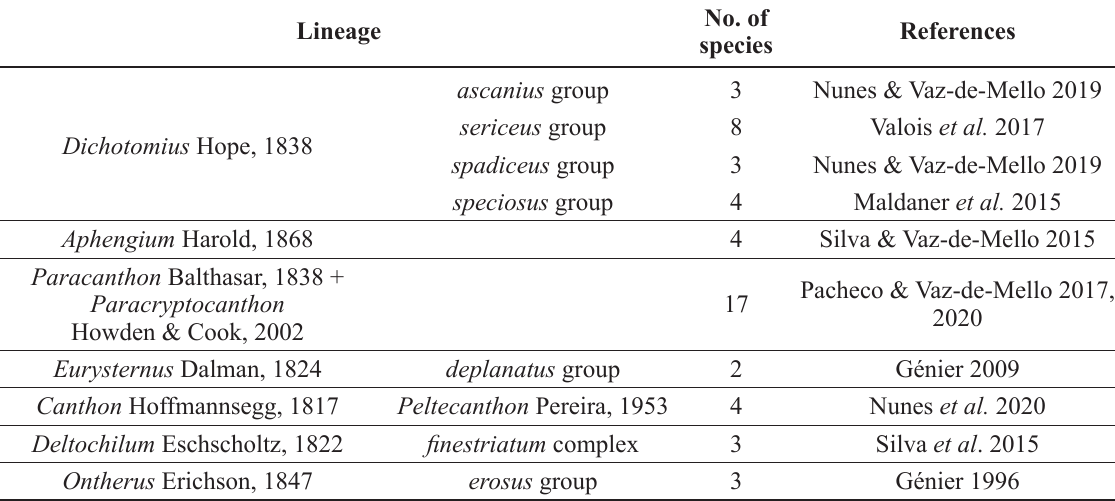
Table 4. Dung beetle lineages endemic to the Atlantic